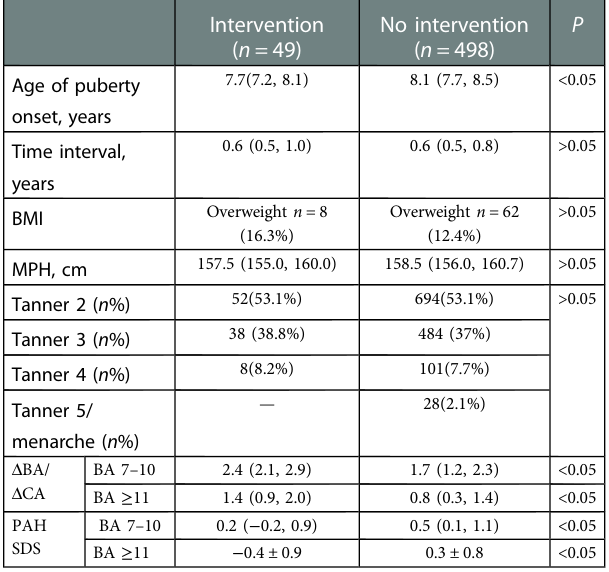
TABLE 1 Comparison of the base data and anthropometric measurements between treated patients with EP and girls with EP who needed no intervention.